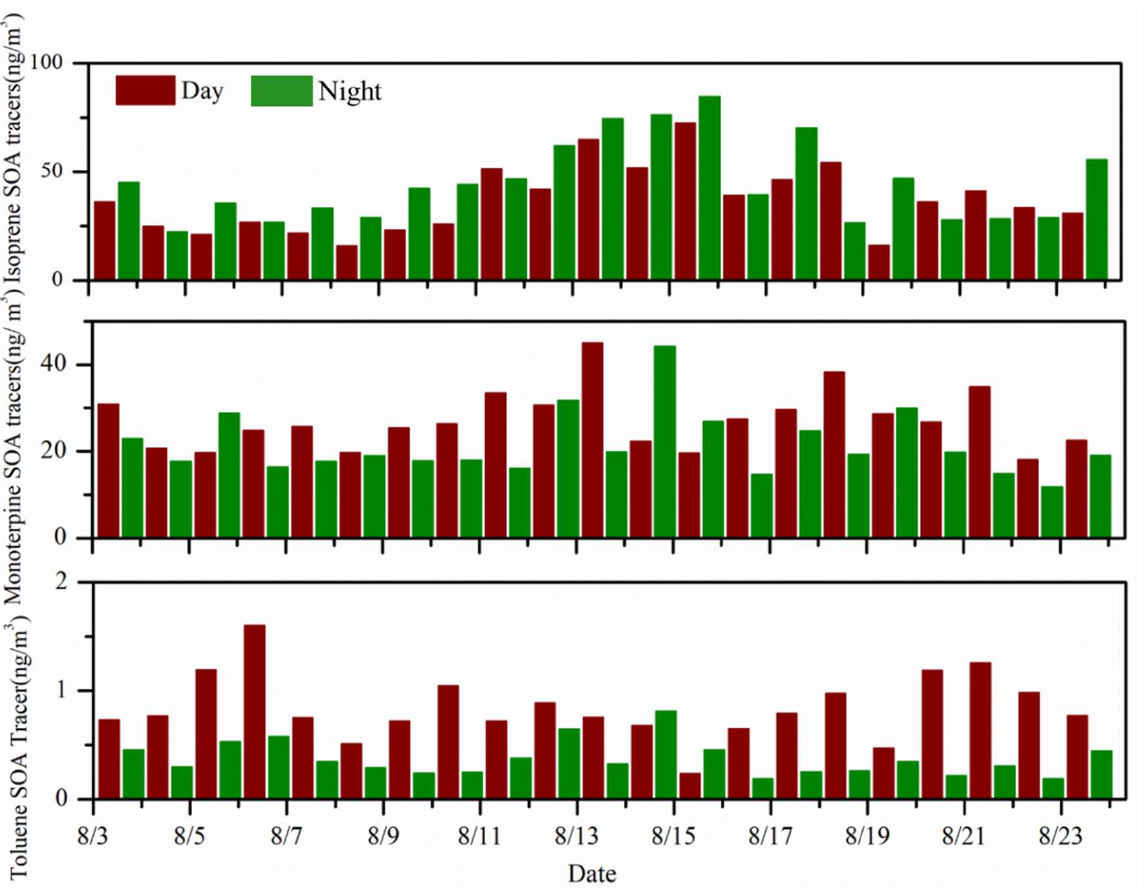
Figure 4. Diurnal variation of mass concentration of each component of SOA tracer.